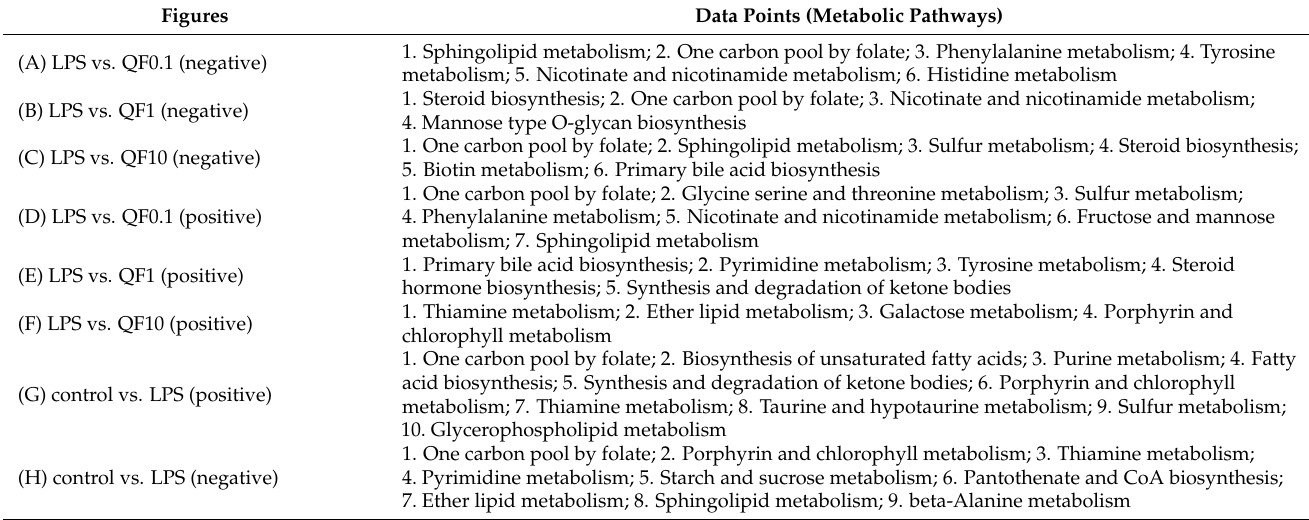
Table 2. Enrichment maps’ description of downregulated metabolic